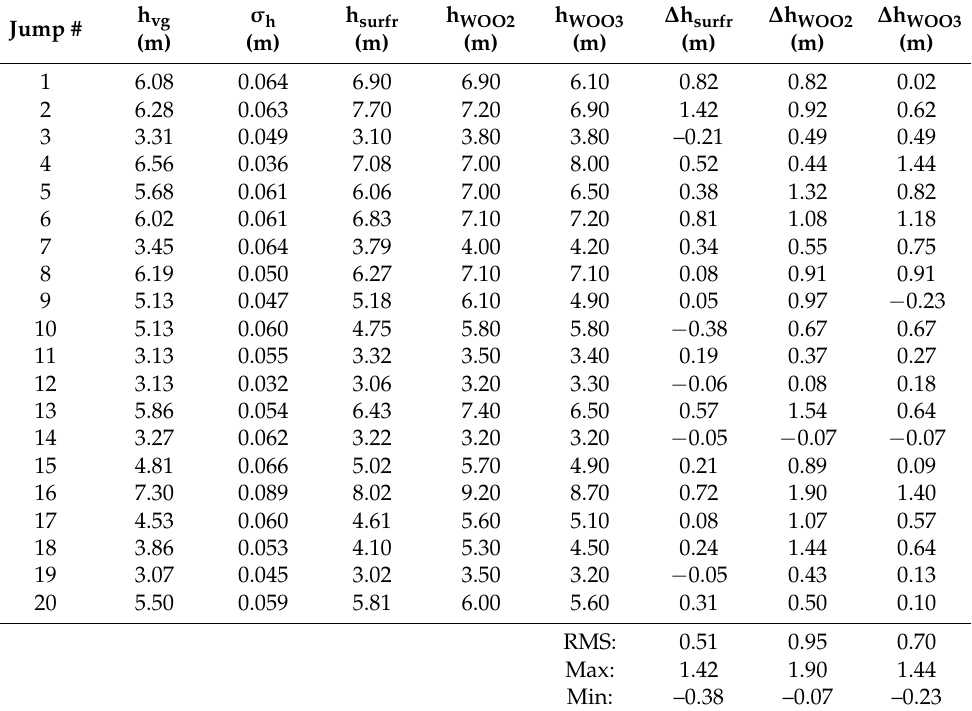
Table 2. Comparison of jump heights determined videogrammetrically and using wearable sensors.